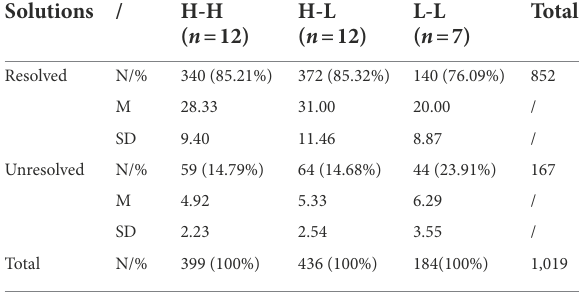
TABLE 4 Solutions of LREs by proficiency